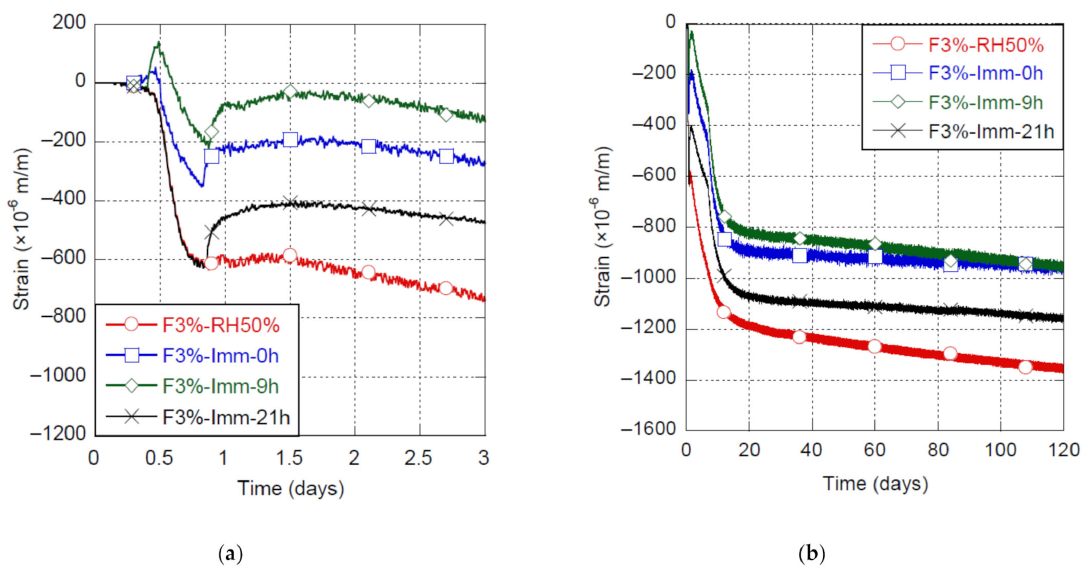
Figure 5. Shrinkage of UHPC-F3% with immersion started at 0, 9 and 21 h, ( a ) early-age shrinkage, ( b ) long-term shrinkage. Table 3. Effect of the immersion on the shrinkage and swelling of the UHPC-F3%.